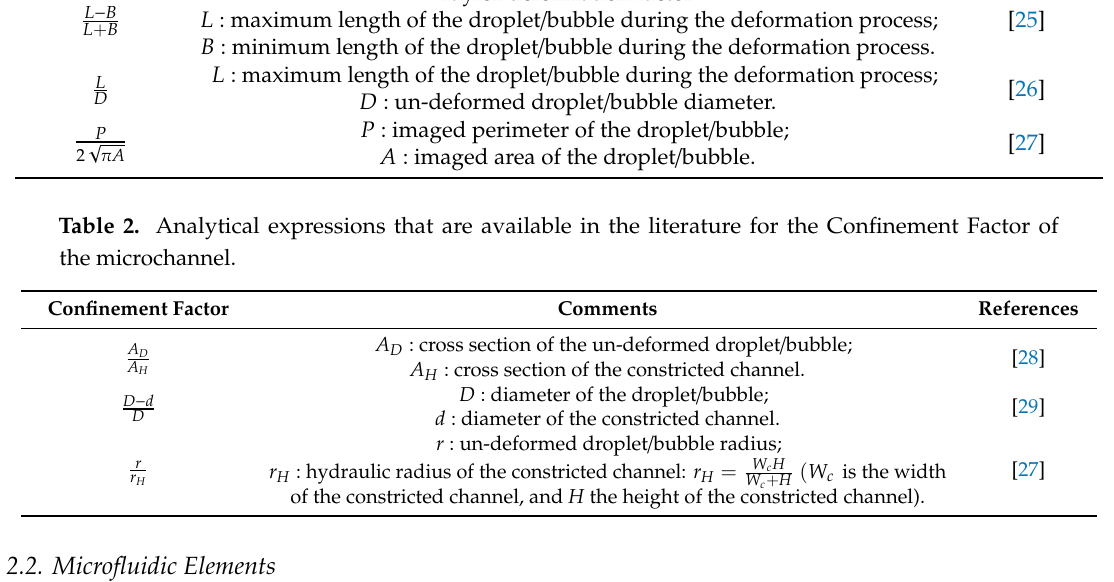
Table 1. Analytical expressions available in the literature for the Deformation Factor of a droplet / bubble. Deformation Factor